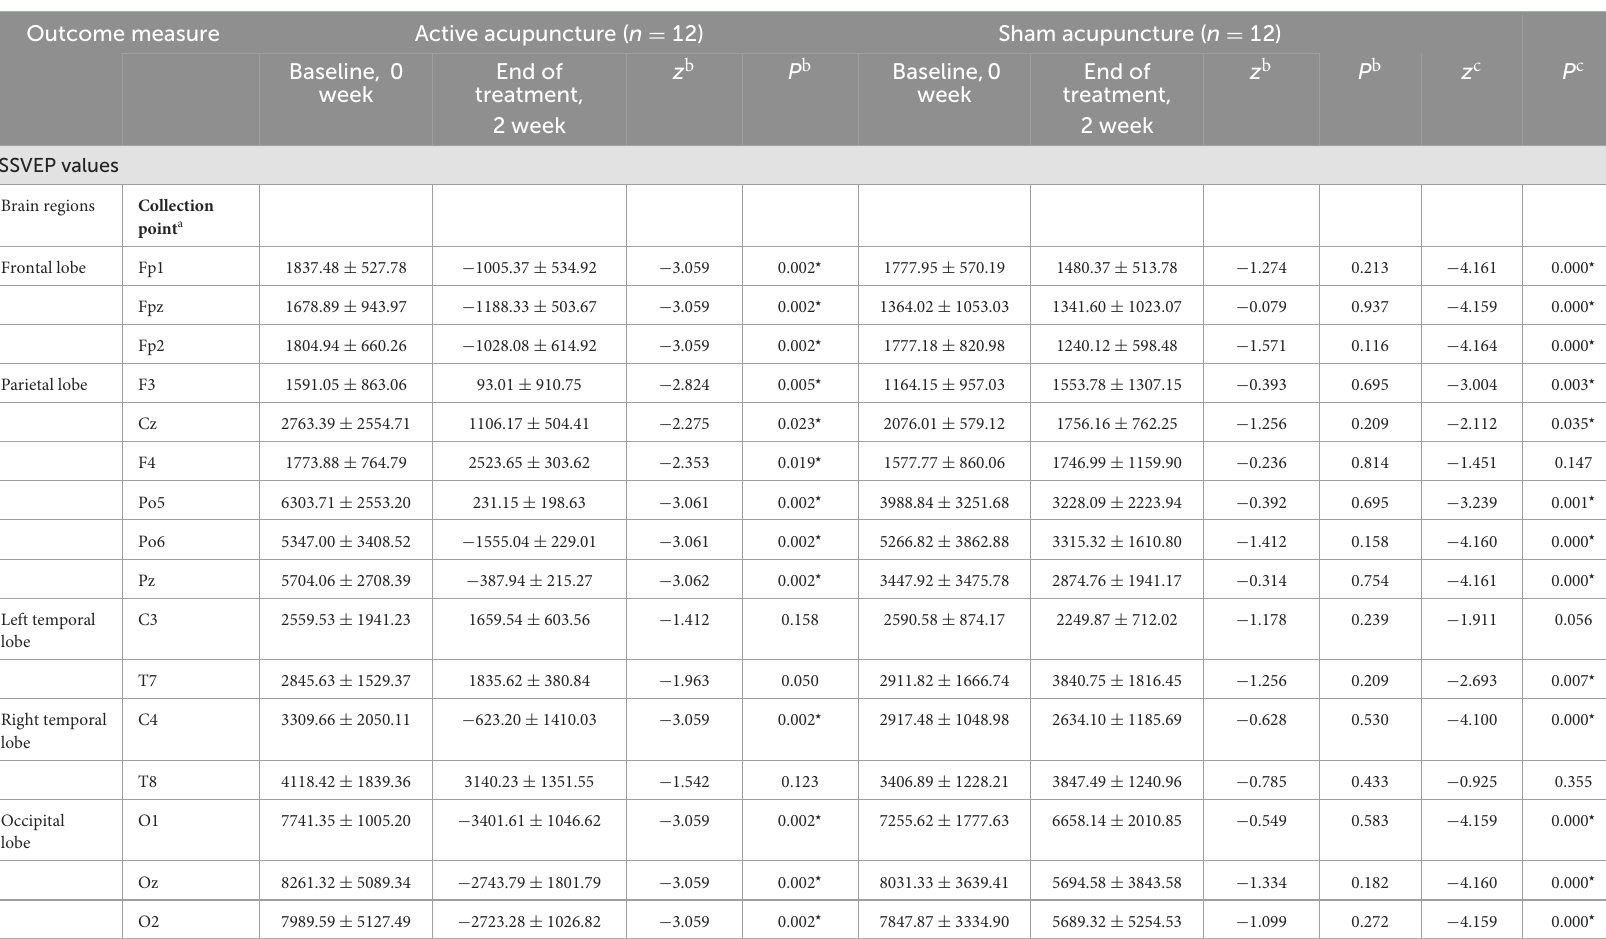
TABLE 6 Secondary outcomes